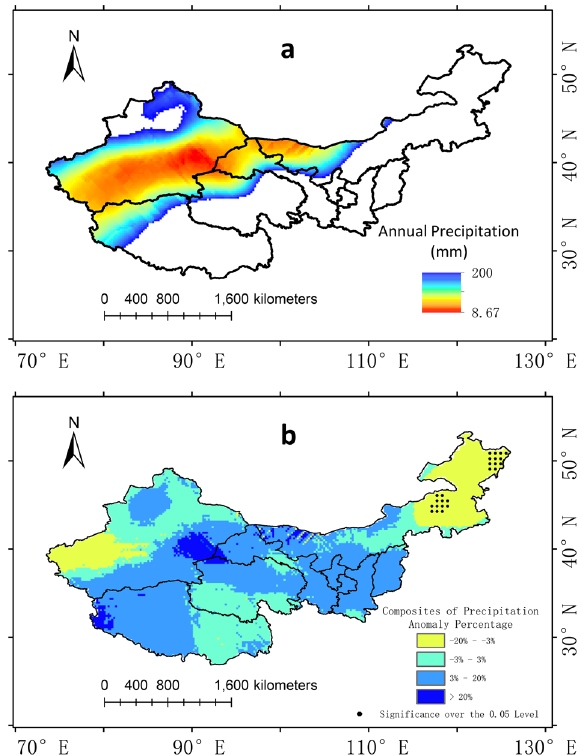
Figure 9. ( a ) The distribution of China’s arid region in La Niña years and ( b ) the composite annual precipitation anomaly percentage. The dotting represents the 0.05 significance level. The maps are generated with Arc Map version 10.5 (http:// www. esri. com/ sofwa re/